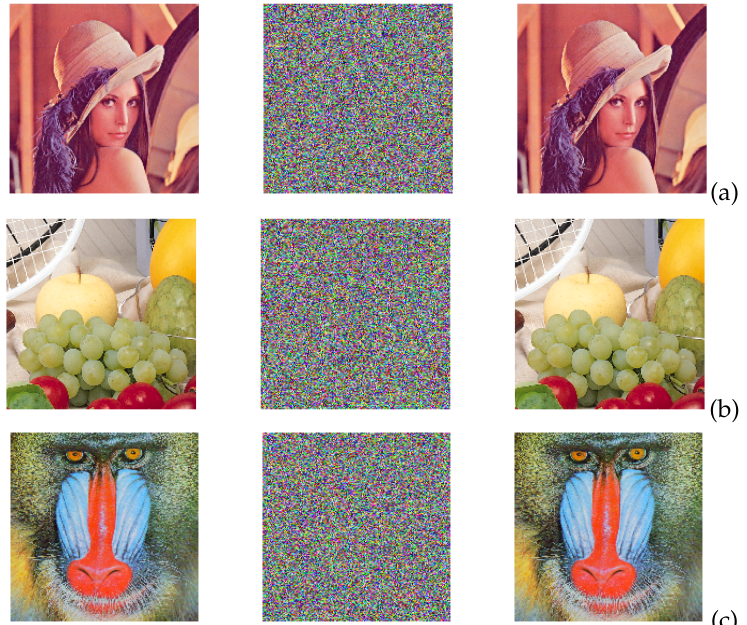
Figure 14. Image encryption of ( a ) Lena, ( b ) Fruits and ( c ) Baboon, using the binary sequences from the FPGA implementation of Hindmarsh–Rose neuron with HRNset1 from Table 7. The original image is on the left, the encrypted in the center and the recovered on the right